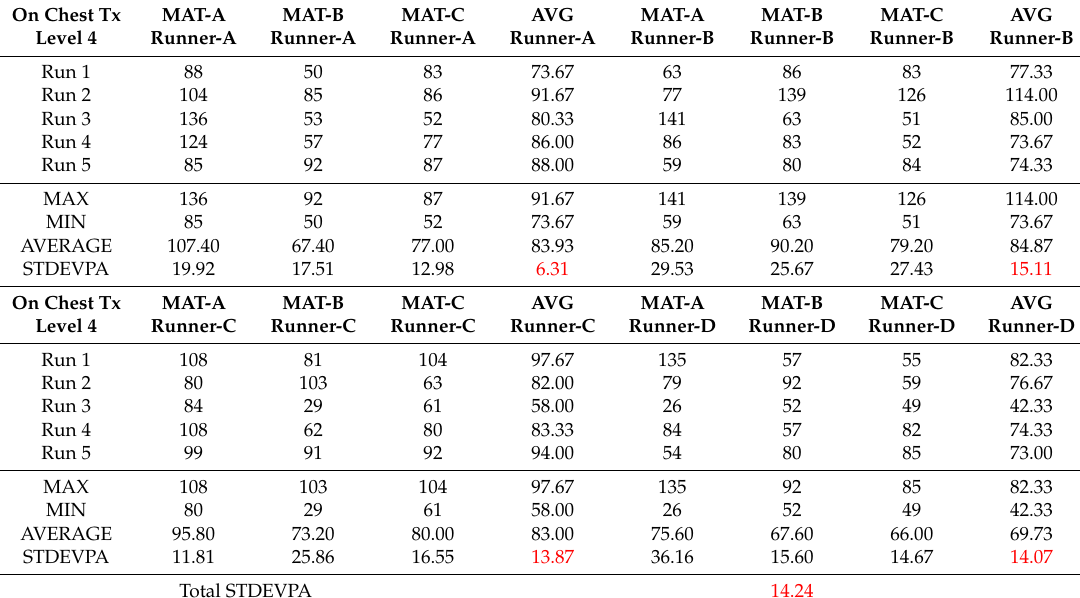
Figure 18. Four runners with a BLE Tag on their respective chests ran through the three sets of MAT one by one. Table 16. The experiment in which four runners with a BLE Tag on their respective insteps ran through three sets of MAT.